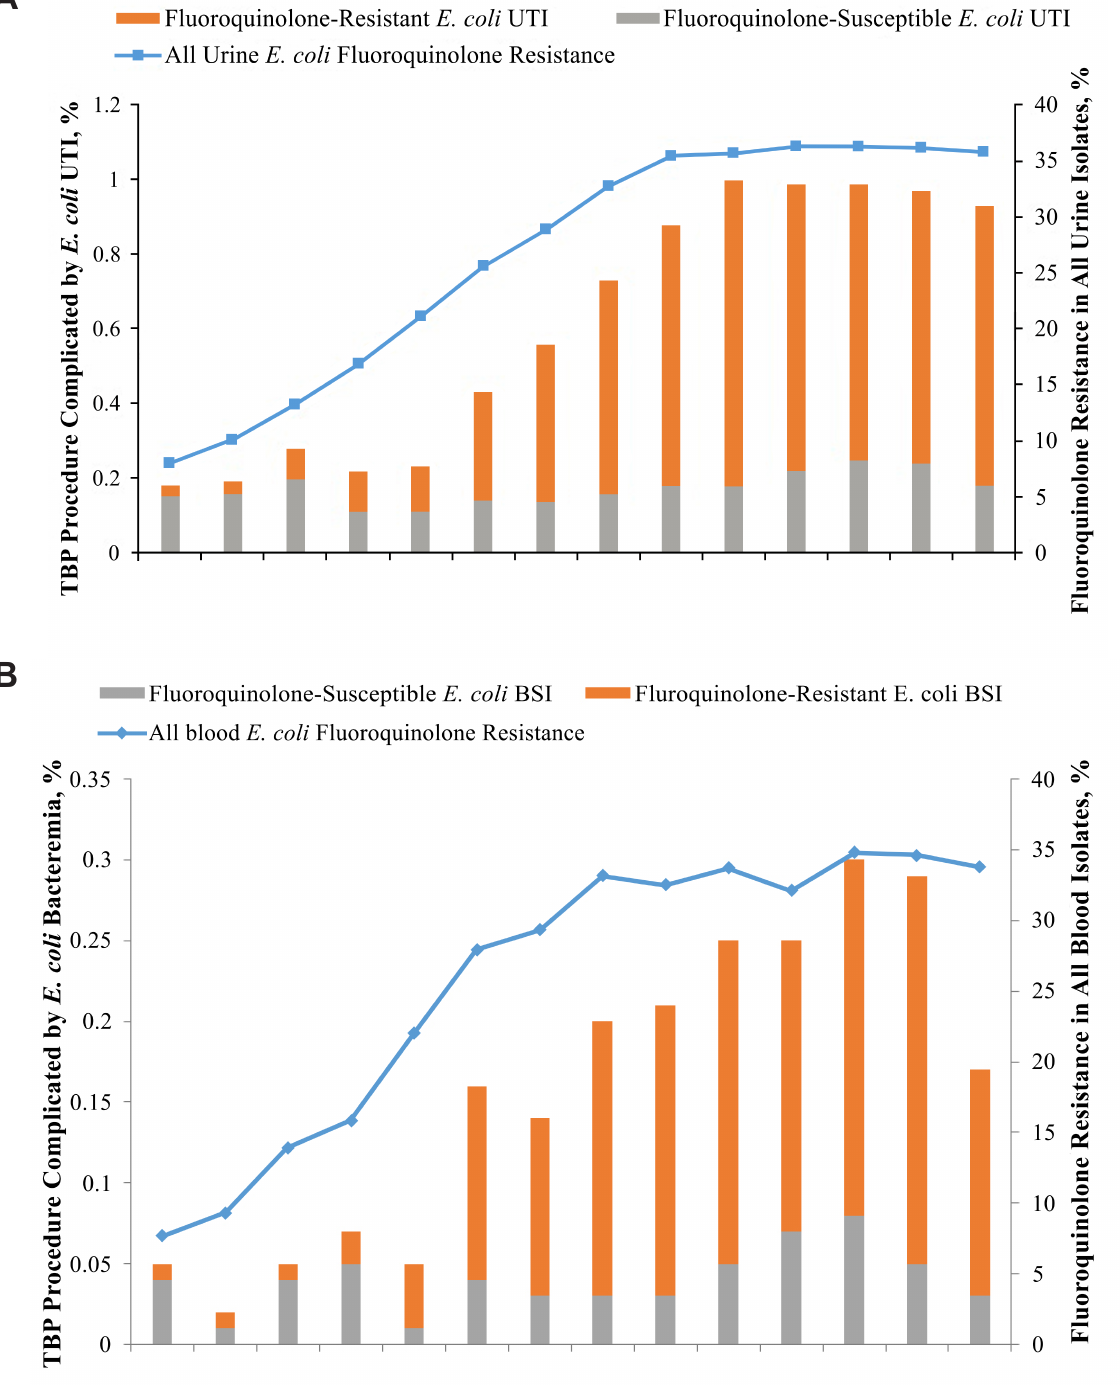
Figure 1. Escherichia coli Infections Following Transrectal Biopsy of the Prostate and Fluoroquinolone Resistance in All E.